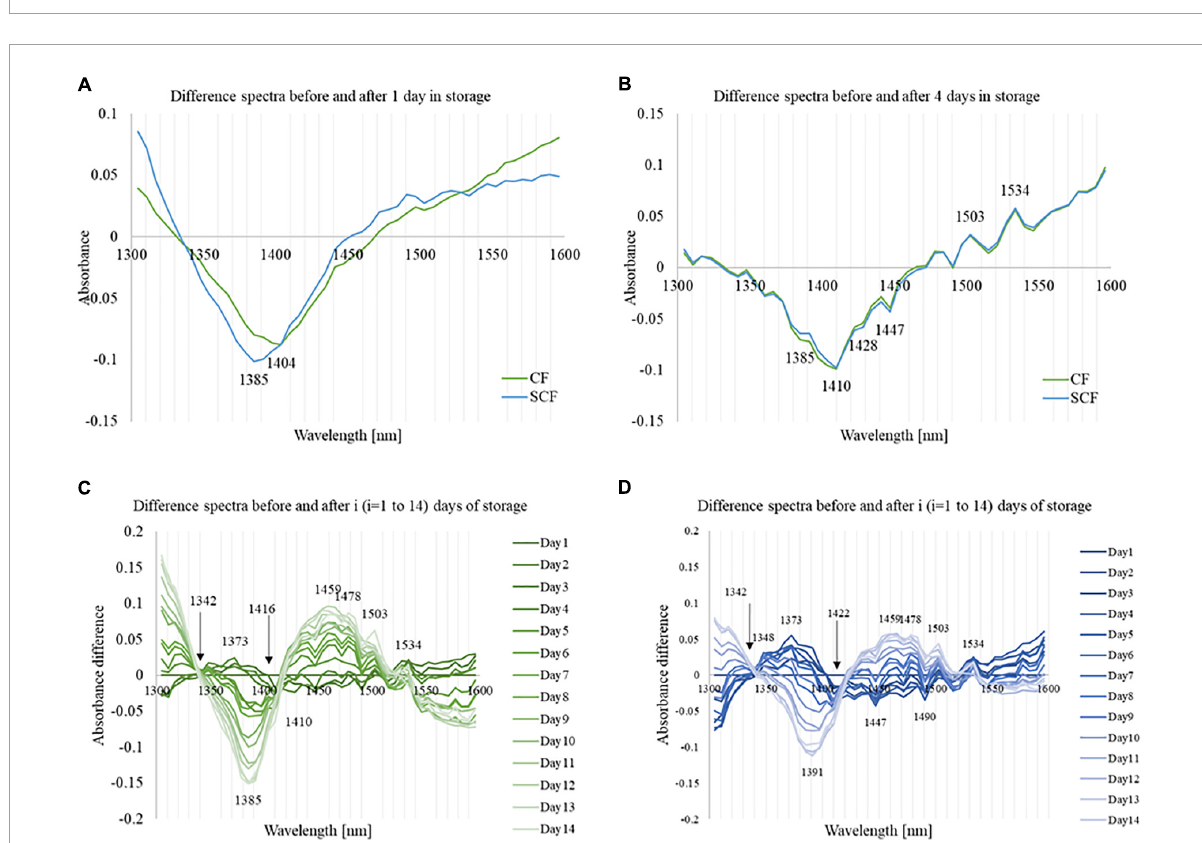
FIGURE4 Difference spectra of the strawberry [Day ( i ) – Day ( 1 ) ] at different times during storage. (A) The difference spectra from day 0 to day 1 showing the impact of low-temperature storage and different cooling systems. (B) The difference spectra from day 0 to day 4 showing initial changes during storage and differences between the cooling systems. (C) The difference spectra of the strawberry [Day ( i ) – Day ( 1 ) ] during the storage in control fridge (CF). (D) The difference spectra of the strawberry [Day ( i ) – Day ( 1 ) ] during the storage in supercooling fridge (SCF).